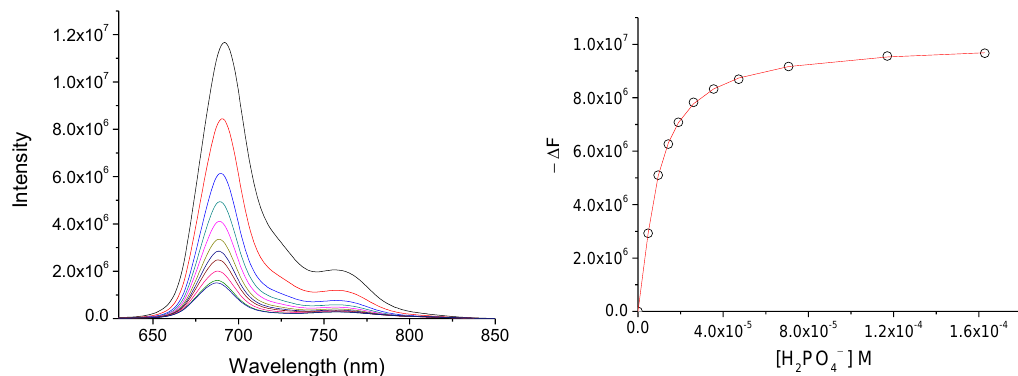
Figure 5. Fluorescence spectra of Pc1 (5.4 × 10 − 6 mol.dm − 3 ) in DMSO upon addition of increasing concentration of H 2 PO 4 − (7.1 × 10 − 3 mol.dm − 3 ) when excited at 600 nm ( left ); and the binding profiles and the generated fit at 688 nm ( right ).